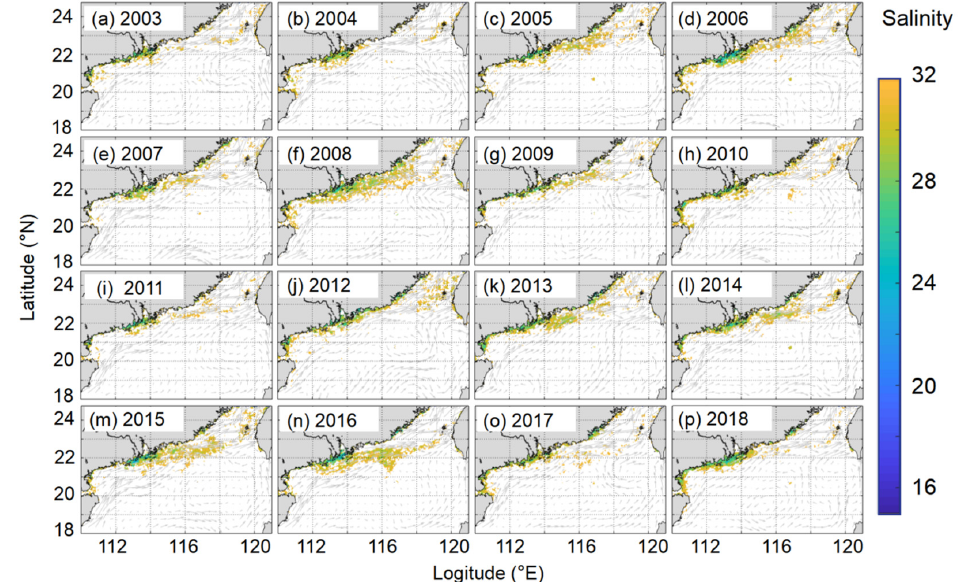
Figure 11. Spatial distributions of low sea surface salinity, SSS (SSS ≤ 32) and surface circulation in the summer during 2003–2018 in the northern South China Sea. The SSS is our reconstructed data; surface circulation data are from https://resources.marine.copernicus.eu/ (accessed on 30 August